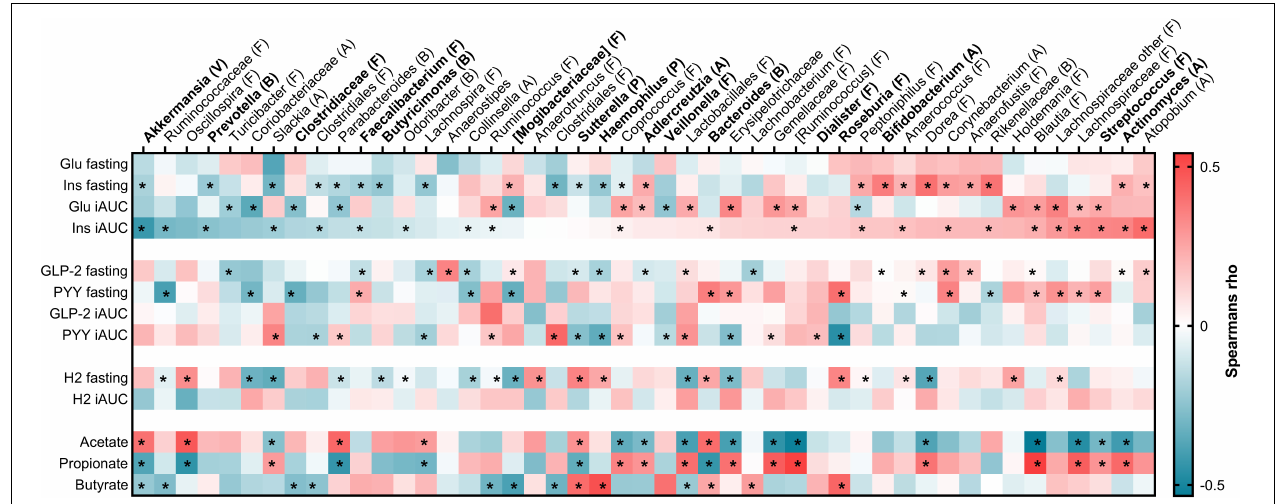
FIGURE 9 | Heatmap of Spearman’s rank correlation coefficient between bacterial taxa and metabolic parameters. The bacterial taxa are sorted from negative (blue) to positive (red) correlation toward insulin iAUC, and those affected by the test meals are indicated in bold. Significant relationship was set to VIP > 1 and indicated by asterisk. No relationship was determined between the bacteria and glucose fasting, GLP-2 iAUC or H2 iAUC. Phyla are indicated within parentheses. A: Actinobacteria; B: Bacteroidetes; F: Firmicutes; Glu: Glucose; GLP-2: Glucagon-like peptide 2; H 2 : Hydrogen; iAUC: Incremental area under the curve; Ins: Insulin; P: Proteobacteria; PYY: Peptide YY; V: